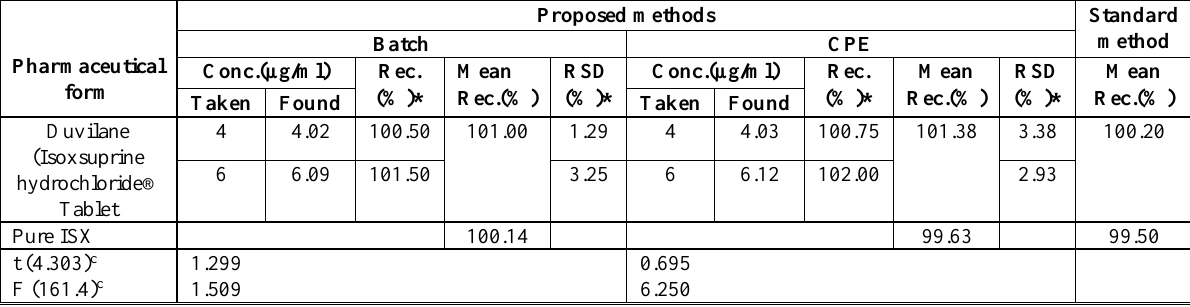
Table 4. Estimation of ISX in tablets using batch and CPE methods compared with standard method